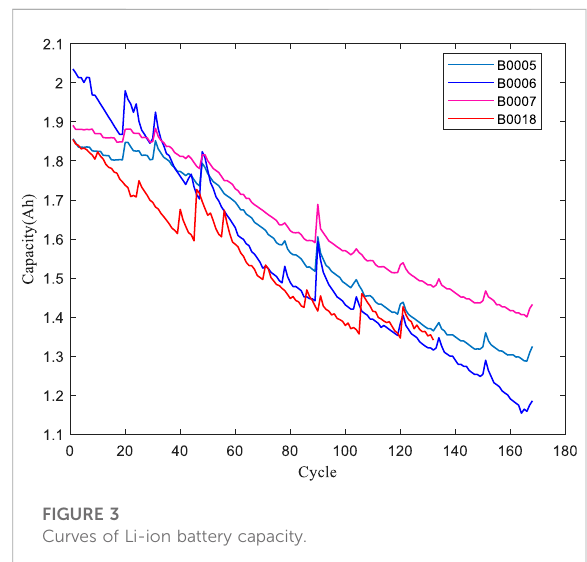
FIGURE 3 Curves of Li-ion battery